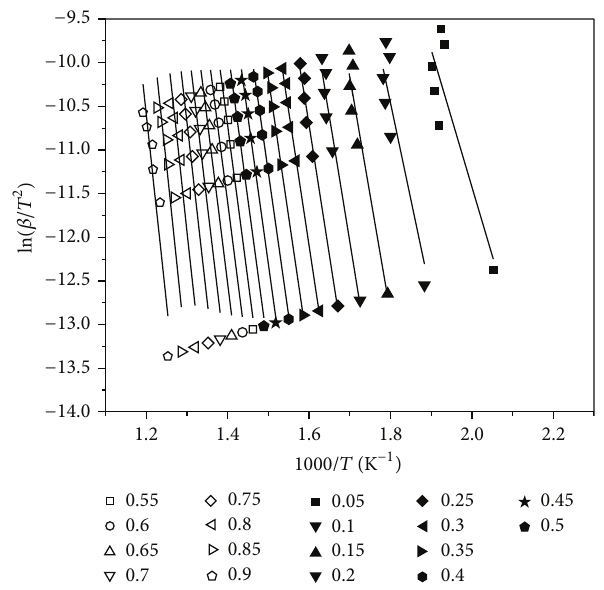
Figure 5: KAS plots of lignite coal pyrolysis at different values of